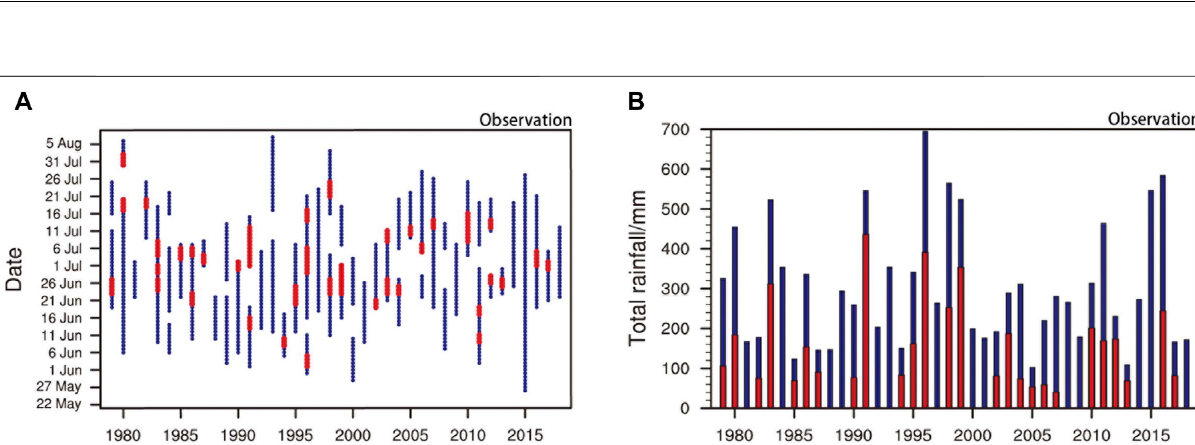
Frontiers in Earth Science |